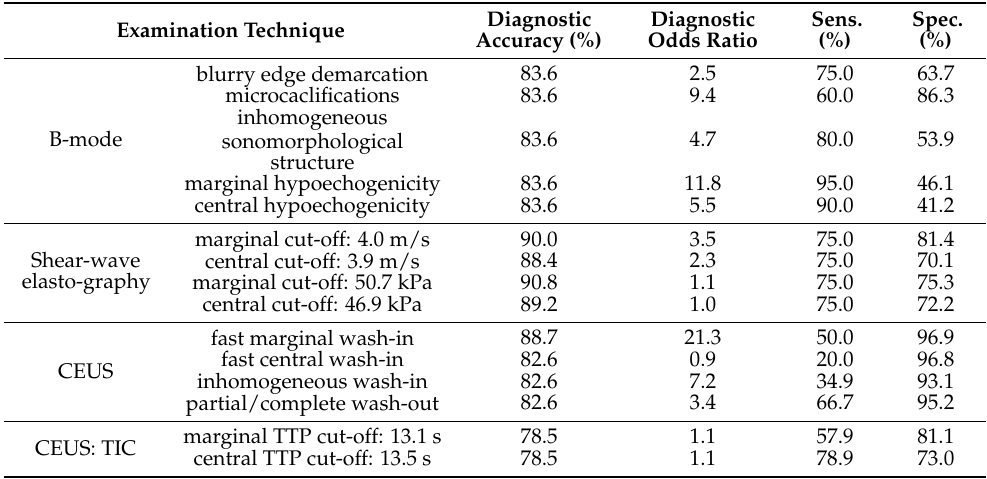
Table 6. Diagnostic accuracy, DOR, sensitivity and specificity for every examination technique.